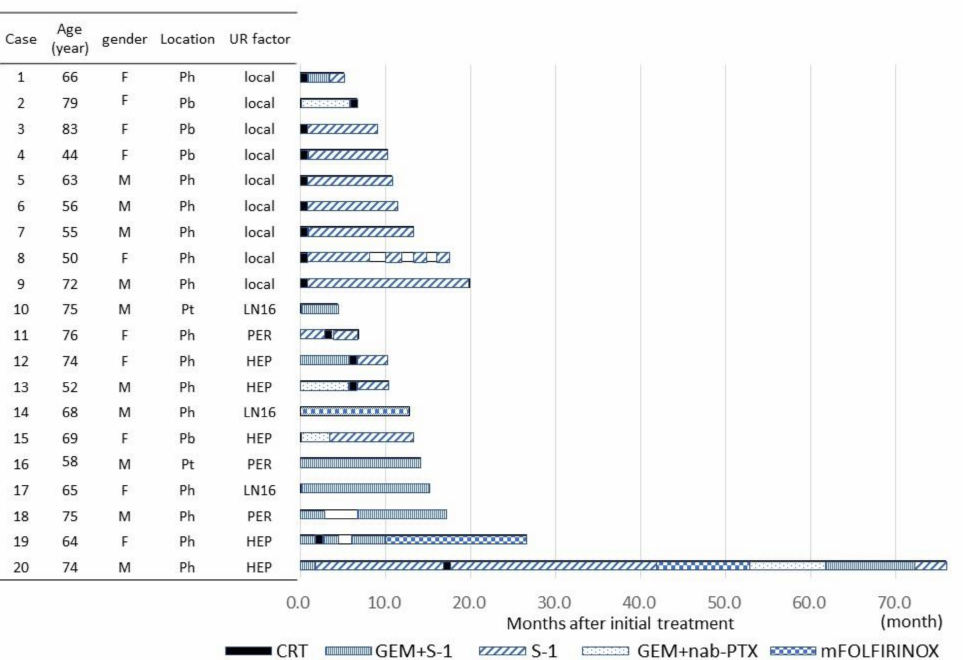
Figure 1. Clinical characteristics of the 20 patients who underwent conversion surgery including therapy before operation. Abbreviations: UR-LA, unresectable locally advanced cancer; UR-M, unresectable cancer with metastasis; M, male; F, female; Ph, pancreatic head; Pb, pancreatic body; Pt, pancreatic tail; LN16, para-aortic lymph node metastasis; PER, peritoneal disseminations; HEP, hepatic metastases; CRT, chemoradiotherapy; GEM, gemcitabine; S-1, oral administration of S-1; nabPXL, nab-paclitaxel; mFOLFIRINOX, modified FOLFIRINOX (combination chemotherapy with fluorouracil, leucovorin, irinotecan, and oxaliplatin).